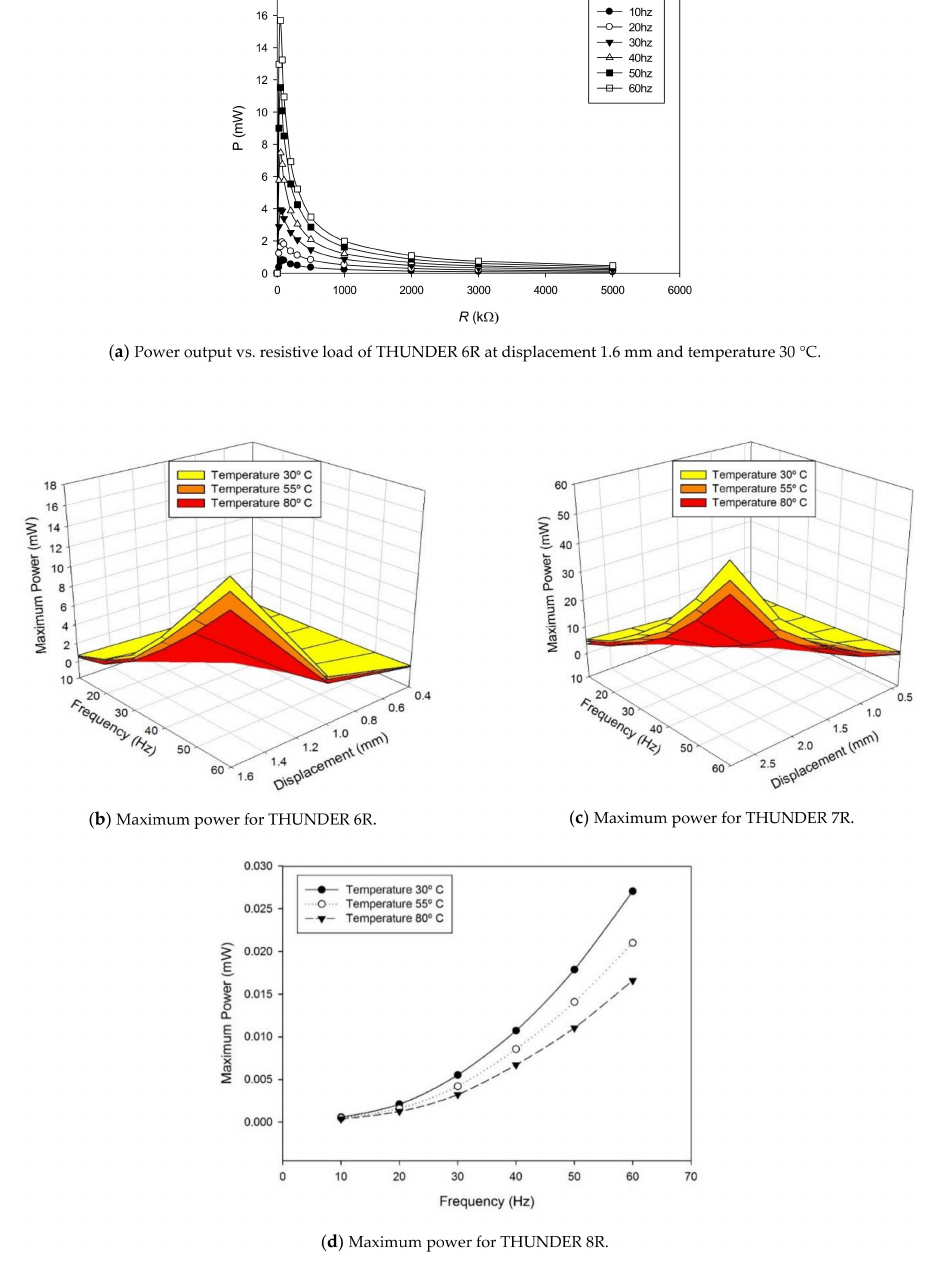
Figure 12. Power output and maximum power variation with input displacement and frequency of the THUNDER devices at different temperatures. ( a ) Power output of THUNDER 6R at displacement 1.6 mm and temperature 30 ◦ C under resistive loads. ( b ) Maximum power of THUNDER 6R. ( c ) Maximum power of the THUNDER 7R. ( d ) Maximum power of THUNDER